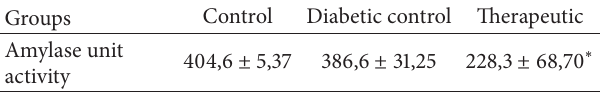
Table 2: Effect of HFME on amylase unit activity in vivo.